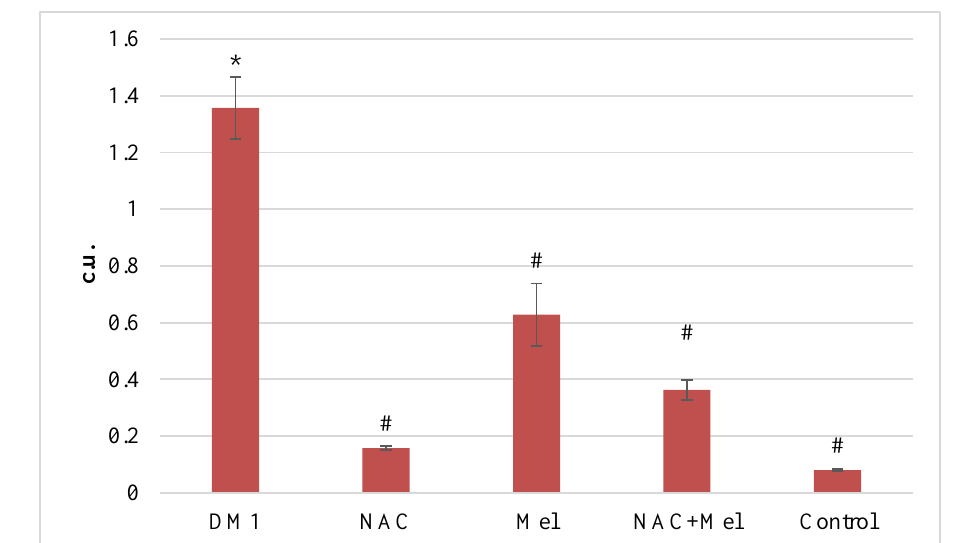
Fig. 4. Changes in the concentration of "free iron" complexes in brain cells of diabetic rats that received a physiological solution and medicinal substances. DM 1 (rats with DM 1 receiving physiological saline per os); NAC (rats with DM 1, administered NAC at a dose of 1.5 g/kg per os); Mel (rats with DM 1, receiving Mel at a dose of 10 mg/kg per os); NAC+Mel (diabetic rats receiving NAC and Mel per os combination therapy); control (intact rats). NAC/Mel or NAC+Mel were administered within 5 weeks; * in comparison with control, p<0,05; # in comparison with DM 1,